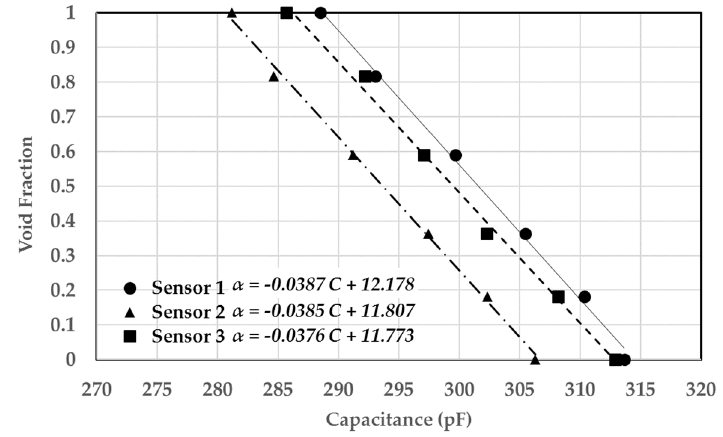
Figure 32. Calibration curve for air–castor oil conditions using foam spheres for the three-sensor configuration (correlation coefficient R = 0.97).